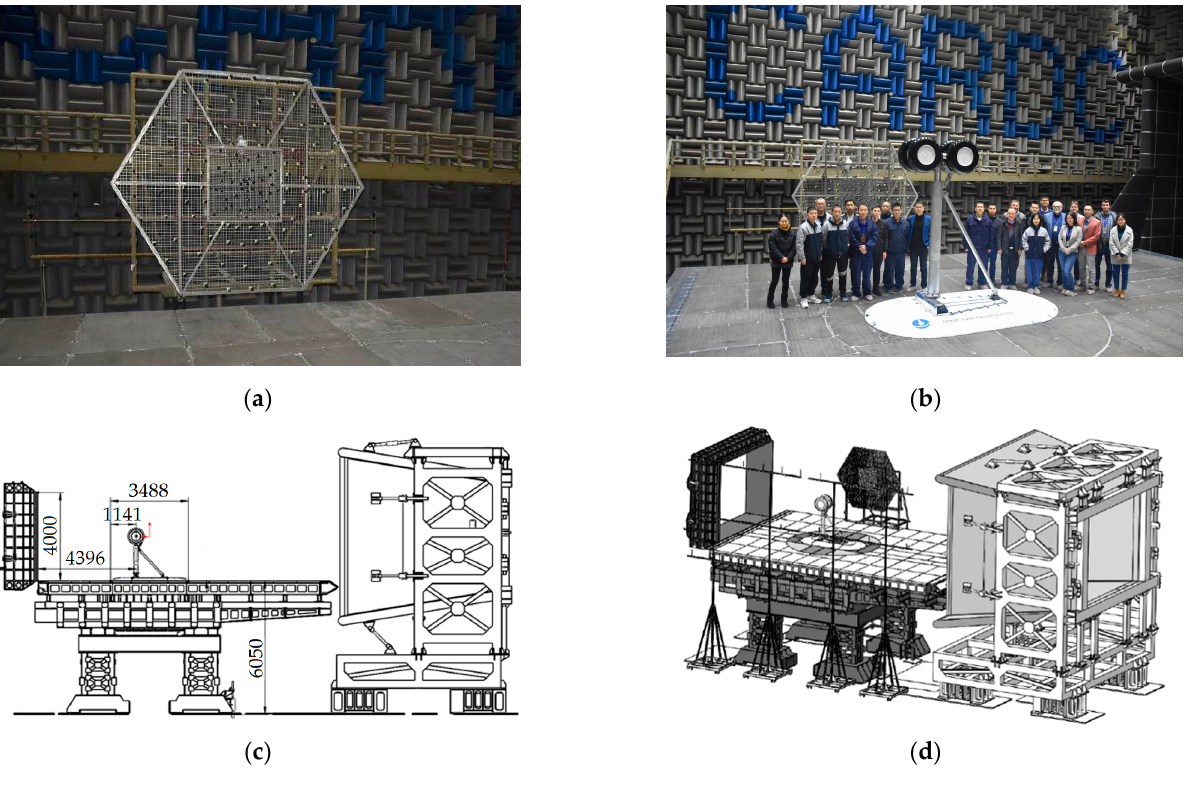
Figure 5. Landing gear noise tests in FL-17 CARDC: ( a ) photo of the beamforming microphone array; ( b ) photo of a landing gear model in FL-17 CARDC; ( c ) 2D scheme of acoustic tests in FL-17 CARDC; ( d ) 3D scheme of acoustic tests in FL-17 CARDC.